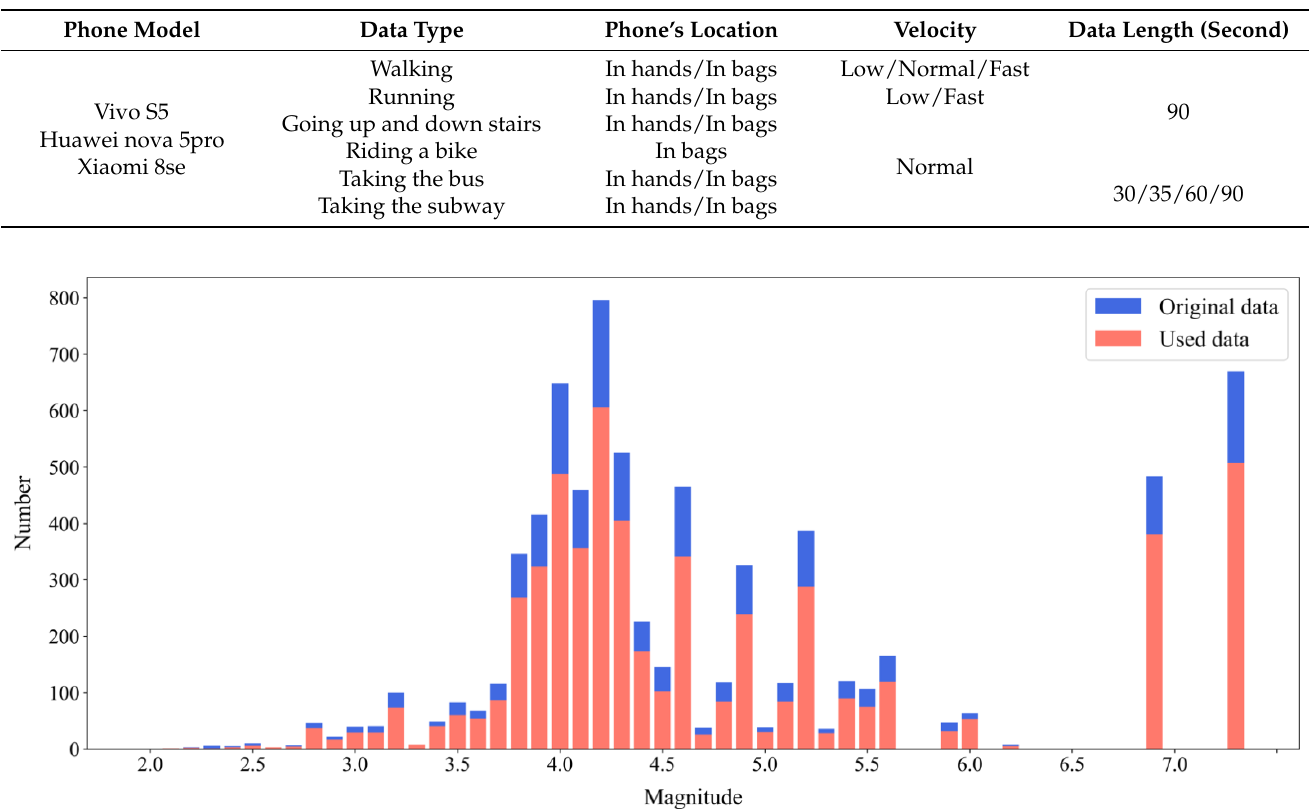
Table 1. Details of mobile phone model and data type.